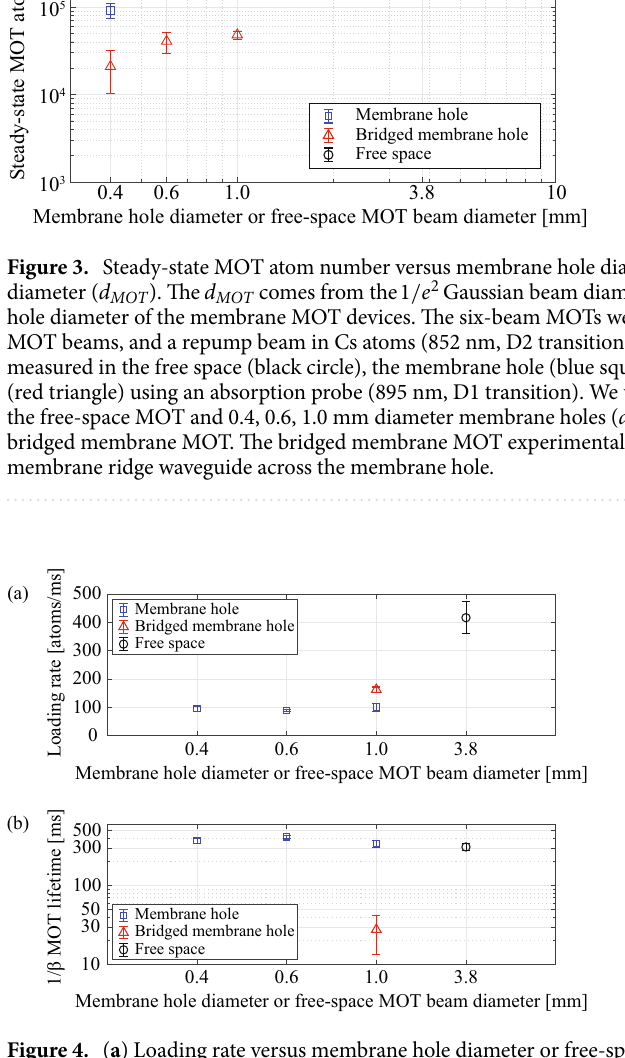
Figure 4. ( a ) Loading rate versus membrane hole diameter or free-space MOT beam diameter. ( b ) MOT lifetime versus membrane hole diameter (or free-space MOT beam diameter). We measured the loading rates and lifetimes of generated MOT atoms in the free space (black circle), the membrane hole (blue square), and the bridged membrane hole (red triangle). Loading rate and MOT lifetime were measured with an absorption probe. We used 3.8 mm diameter beams ( d MOT ) for the free-space MOT (black circle) and 0.4, 0.6, 1.0 mm-diameter membrane holes ( d Hole ) for the membrane MOT (blue square) and the bridged membrane MOT (red triangle). The bridged membrane MOT experimentally simulates the situation of a 3- µ m-width membrane ridge waveguide across the membrane